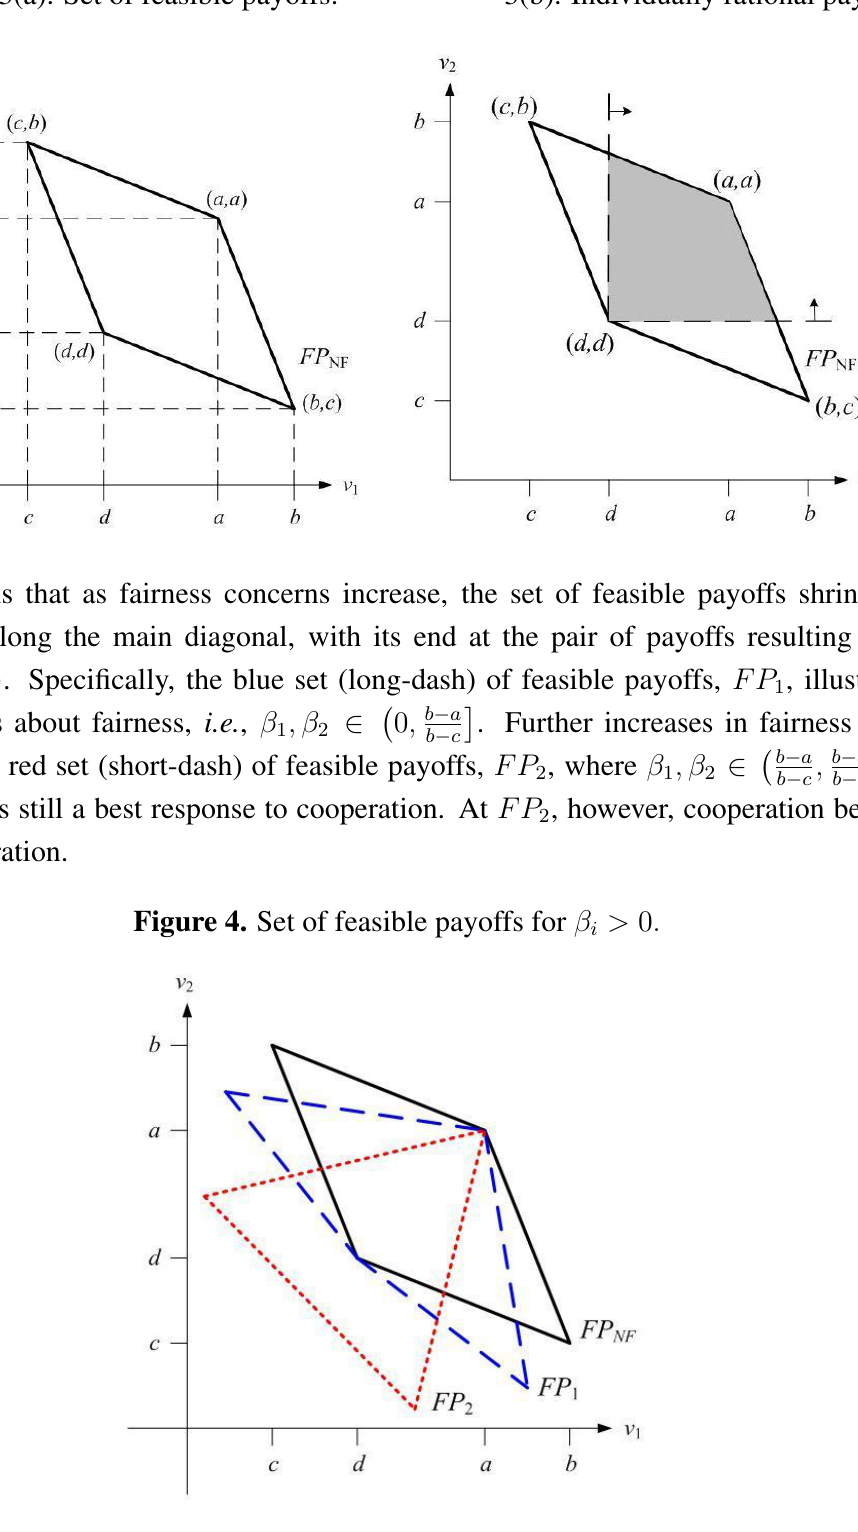
Figure 3. 3(a). Set of feasible payoffs.